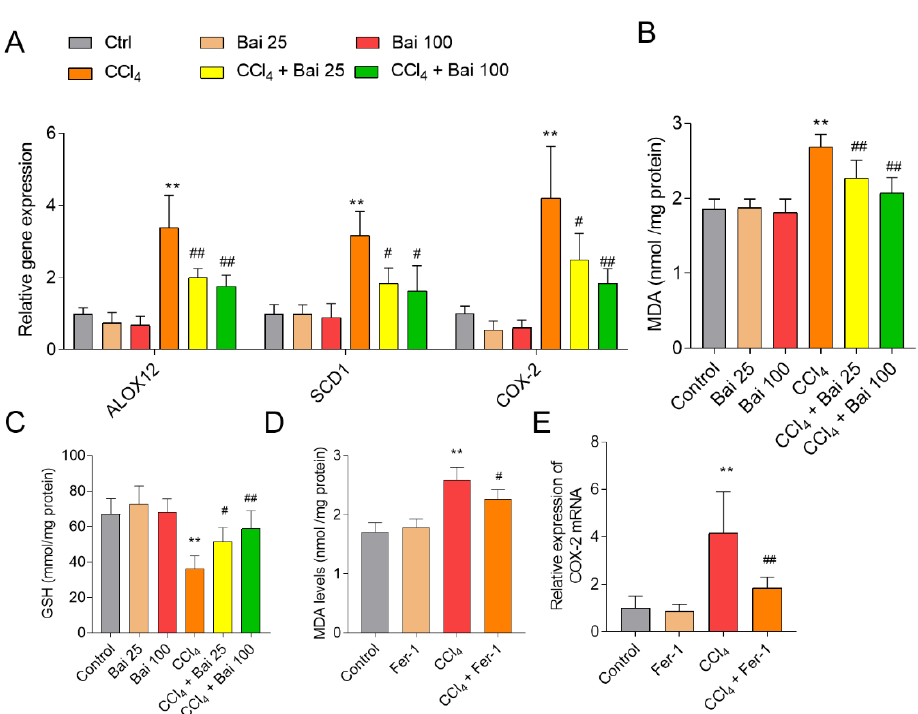
Figure 4. Effects of baicalein and Fer-1 supplementation on the expression of COX-2 , lipid peroxidation and GSH in the liver tissues of mice challenged with CCl 4 . ( A ) Effect of baicalein supplementation on expression of ALOX12 , SCD1 , and COX-2 mRNAs in liver tissues. ( B ) Effect of baicalein supplementation on the levels of MDA in liver tissues. ( C ) Effect of baicalein supplementation on the levels of reduced GSH (shown as GSH) in liver tissues. ( D ) Effect of Fer-1 supplementation on the levels of MDA in liver tissues. ( E ) Effect of Fer-1 supplementation on the expression of COX-2 mRNA in liver tissues. All data are presented as mean ± SD ( n = 6). ** p < 0.01, compared to the untreated control group, respectively; # p < 0.05 or ## p < 0.01 compared to the CCl 4 -only group. MDA: malondialdehyde; GSH: glutathione; Bai: